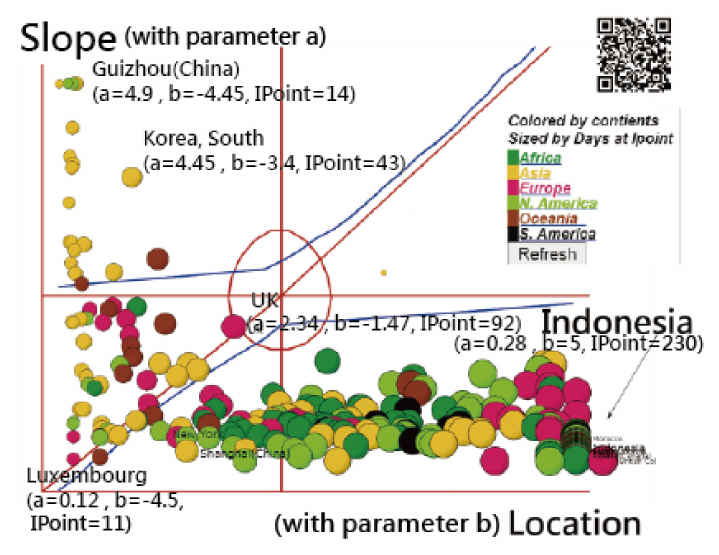
Figure 6. Similarity of the epidemic trend using the item response model (IRT) and Kano models to display the results (Note: readers are invited to scan the QR-code to examine the detail on a dashboard).